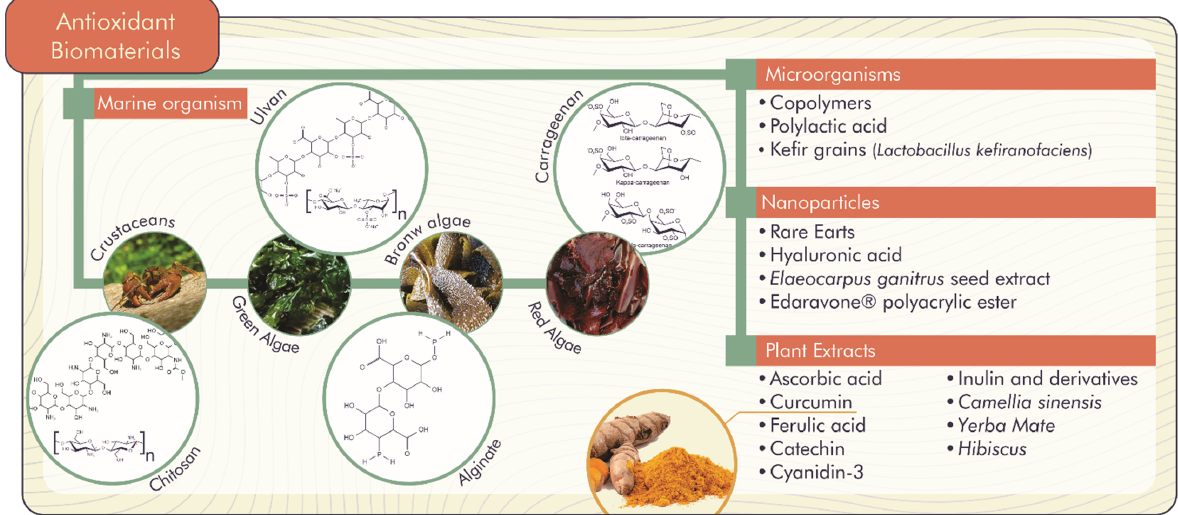
Figure 3. Natural antioxidant biomaterials with important biological